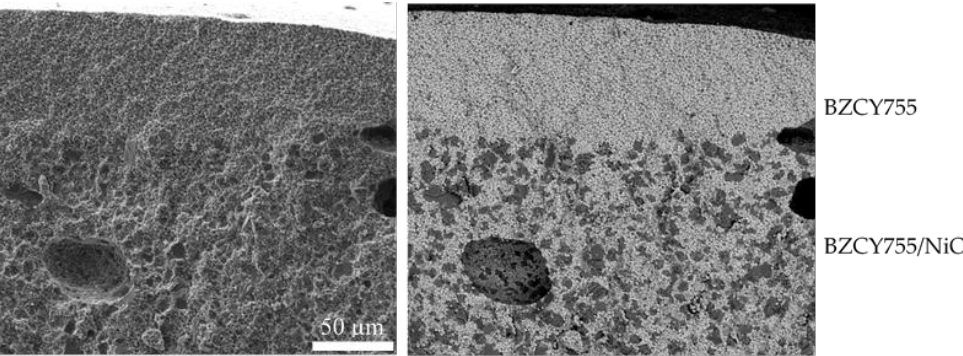
Figure 10. Secondary electron ( left ) and back-scattered electron ( right ) micrographs of a thin BZCY755 film painted and co-fired onto the flat side of the polymer clay channelized 50 / 50-BZCY755 / NiO sample (fractured cross section). (BZCY: light phase, NiO: grey phase).